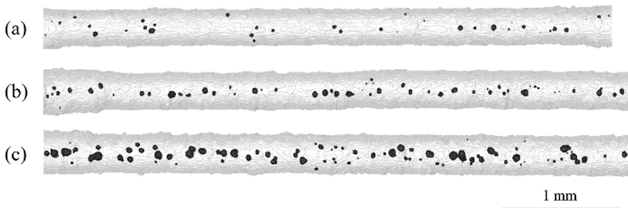
Figure 5. Reconstructed 3D images of µCT scans of ( a ) specimen C5-A, ( b ) specimen C5-G and ( c ) specimen C5-C showing segmented struts with pores in black. Struts within the same type of scanning strategy show high reproducibility in terms of dimensional accuracy but also variations in pore volume (( a ) = 0.15%, ( b ) = 0.37%, ( c ) = 1.28%).